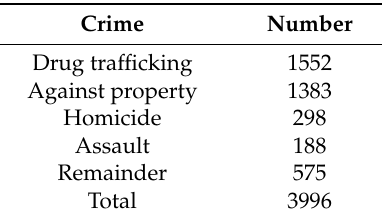
Table 1. Types of offences for which women receive custodial sentences.